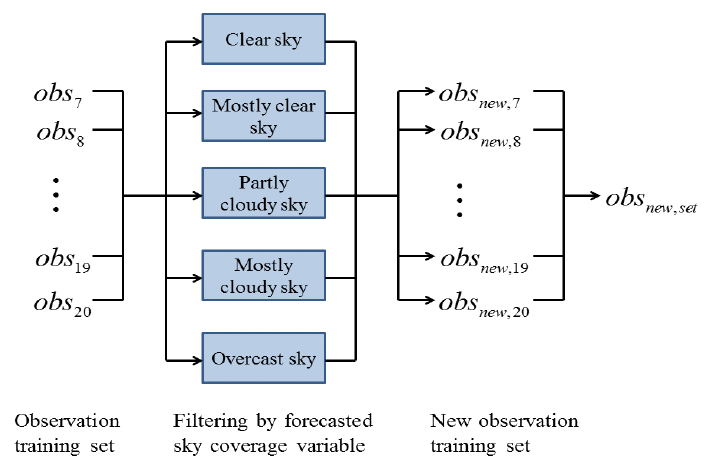
Figure 4. Filtered training set using the forecasted sky coverage variable (step 2).